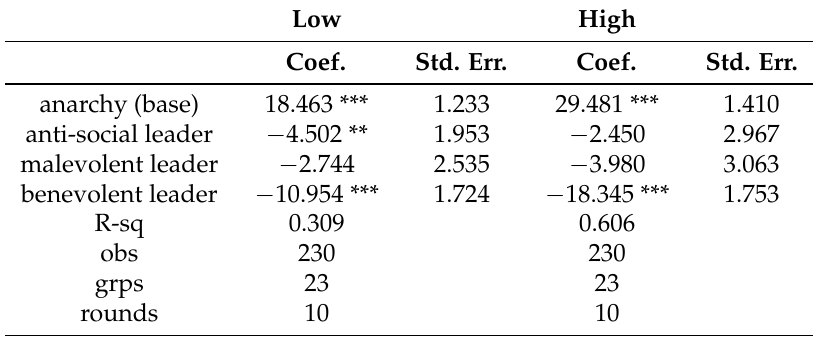
Table 5. Impact of leader behavior on within-group conflict. Random error-Generalized least squares regression with robust standard errors clustered across groups; Dependent variable: group fighting.